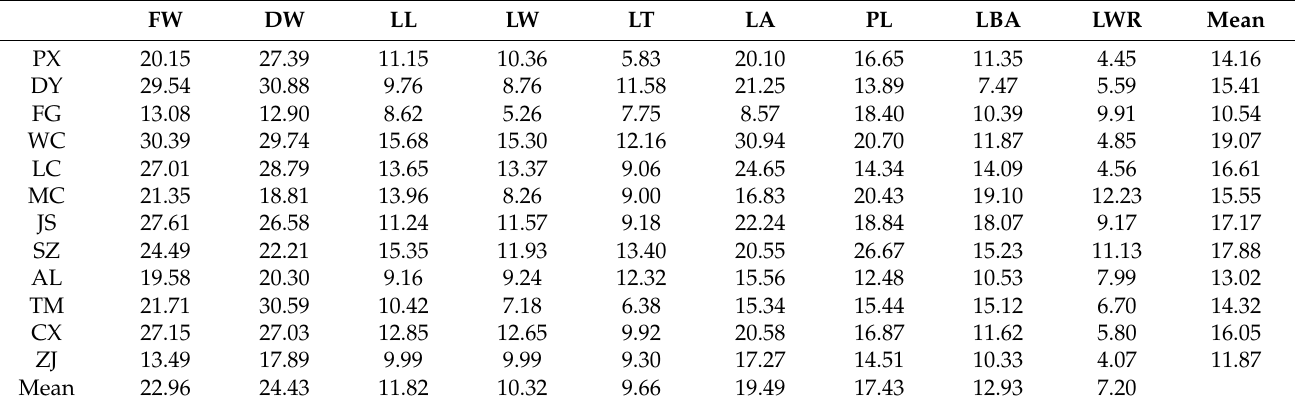
Table 3. The coefficients of variation (CV) within the G. biloba populations. The leaf traits in this study include fresh weight (FW), dry weight (DW), leaf length (LL), leaf width (LW), leaf